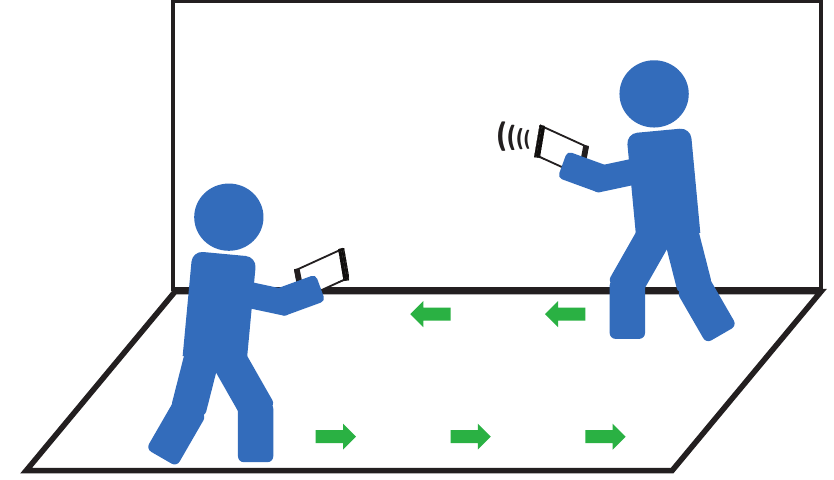
Figure 3. Indoor pedestrian encounter model for infrastructure-free indoor pedestrian tracking